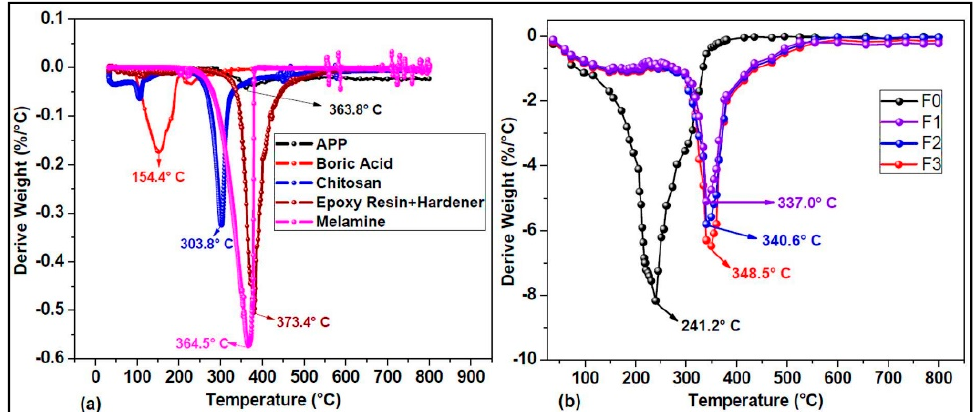
Figure 12. Di ff erential thermogravimetric (DTG) graph of the ( a ) individual components and ( b ) flame retardant samples.